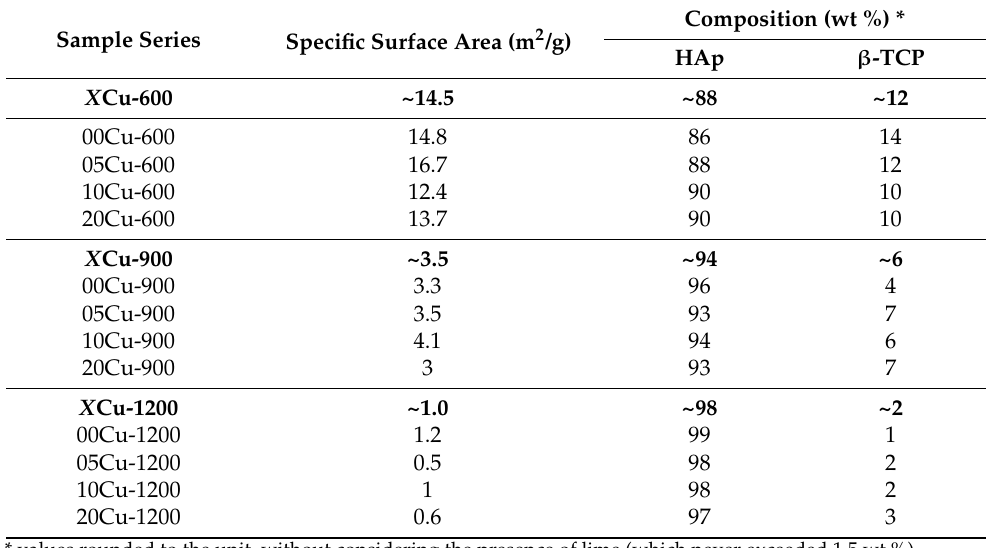
Table 1. Specific area and mineral composition (weight percent, wt %) of the three series of sintering temperatures ( X = 00, 05, 10 and